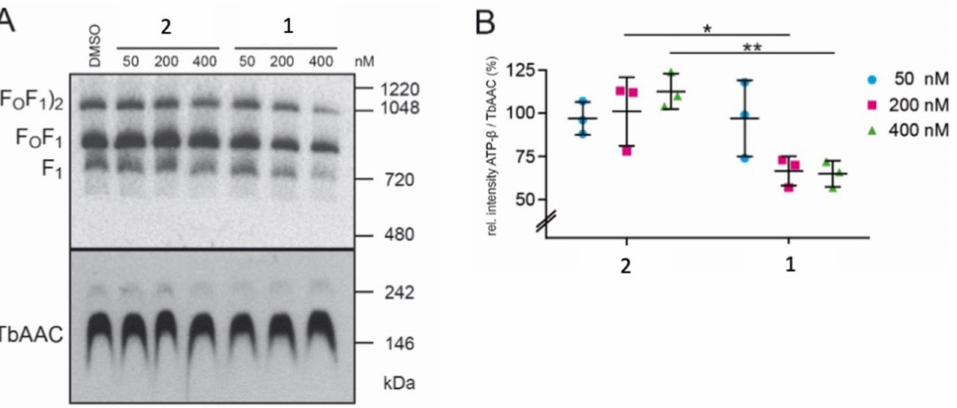
Figure 9. Native PAGE analysis and quantification of ATP-synthase complexes. ( A ) shows native PAGE and immunoblot analyses of mitochondria-enriched membranes after treatment with DMSO (mock control), or compound 1 or 2 for 1 h. ATP synthase F 1 and F o F 1 monomers and dimers ((F o F 1 ) 2 ) were visualized using the anti-ATP synthase subunit β antibody (ATP- β ), the loading control TbAAC was visualized with anti-TbAAC antibody. ( B ) shows protein quantification of samples from A analyzed by SDS-PAGE and immunoblotting. Ratios of signal intensities of ATP- β versus TbAAC were compared to DMSO-treated samples (n ≥ 3). * p < 0.05, ** p <